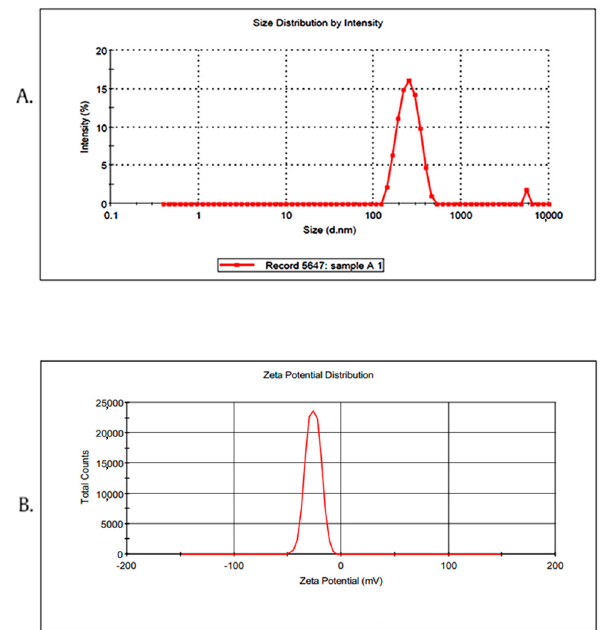
Figure 2. Optimized Ros-LCNPs ( A ) mean particle size, 219.10 nm; polydispersity index (PDI), 0.214; ( B ) zeta potential, − 26.2 mv with 100% peak area.